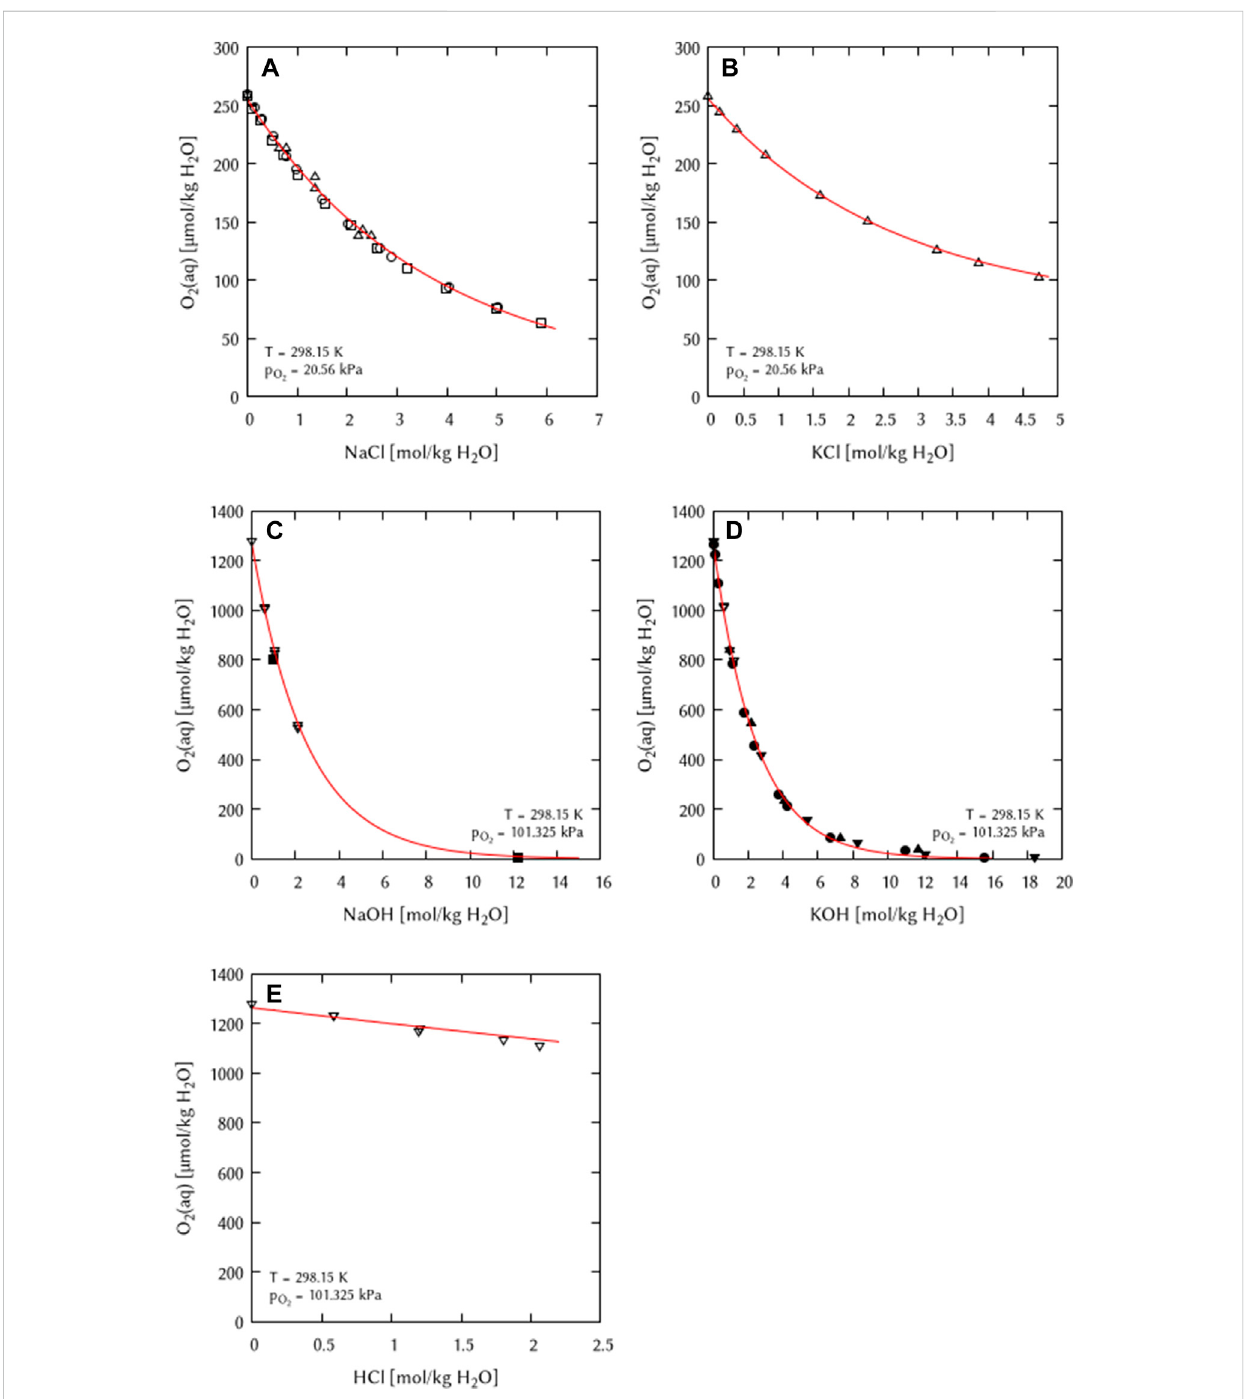
FIGURE 4 ModellingoftheO 2 solubility inbinary solutionsof (A) NaCl, (B) KCl, (C) NaOH, (D) KOH, and (E) HClas afunction oftheelectrolyteconcentrationat T = 298.15 K (Points: Experimental data from: □ Millero et al. (2002a), ○ Millero et al. (2002b), n Millero et al. (2003), ▽ Geffcken (1904), ■ Chatenet et al. (2000), C Davis et al. (1967), ▲ Gubbins and Walker (1965), ▼ Shoor et al. (1968), Lines: this